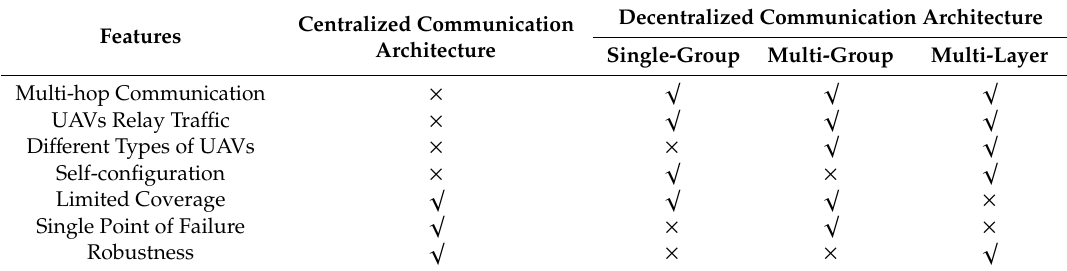
Table 2. Summary of Communication